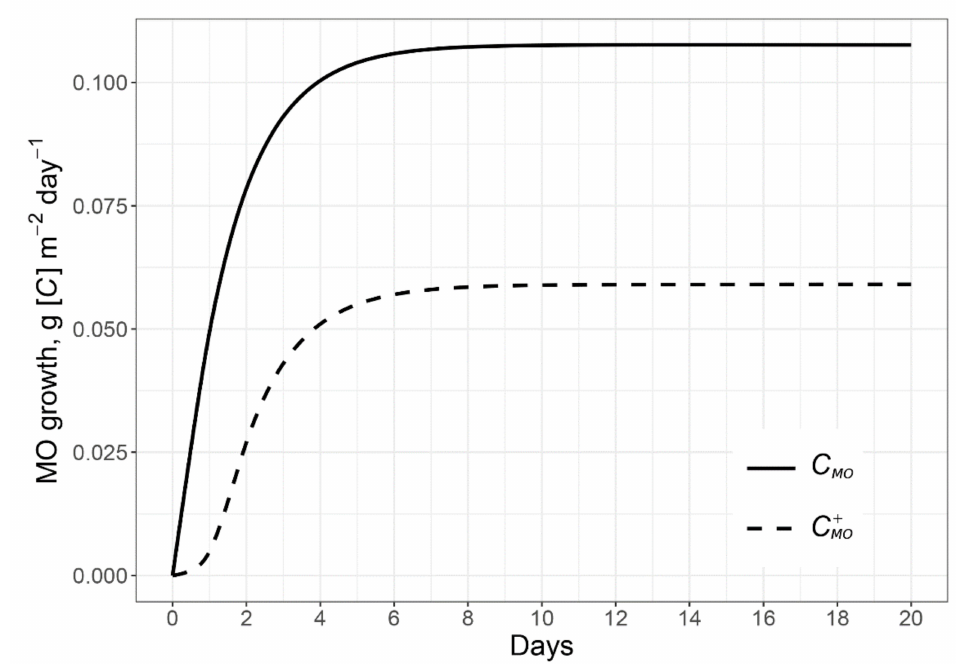
Figure 5. Simulated dynamics of microbial growth due to exudates (RE) input at the scale of rhizosphere soil. C MO —microbial biomass growth using C and N of exudates; C + biomass growth due to N mining for the microbial growth using the residual exudates C; RE input equals 0.5 g [C] m − 2 day − 1 .